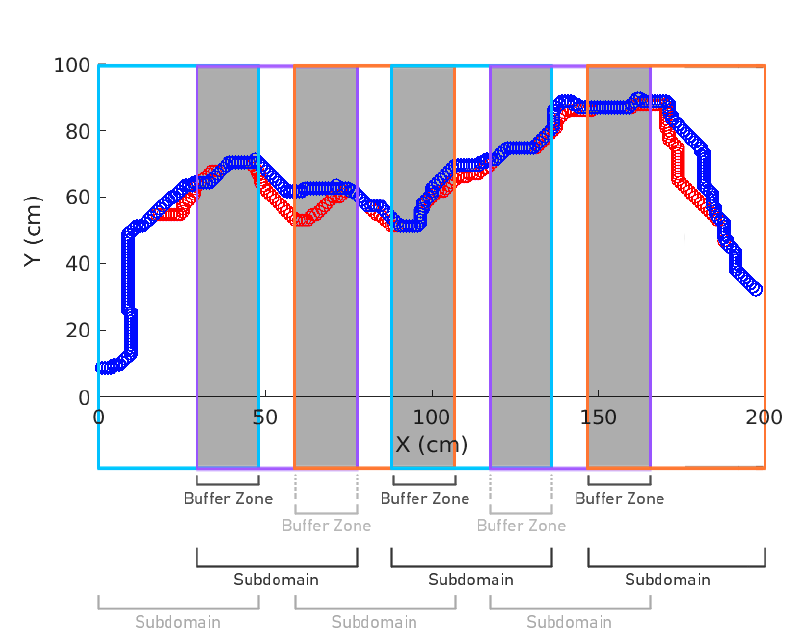
Figure 10. A visualization of the subdomain and buffer zone system applied to Figure